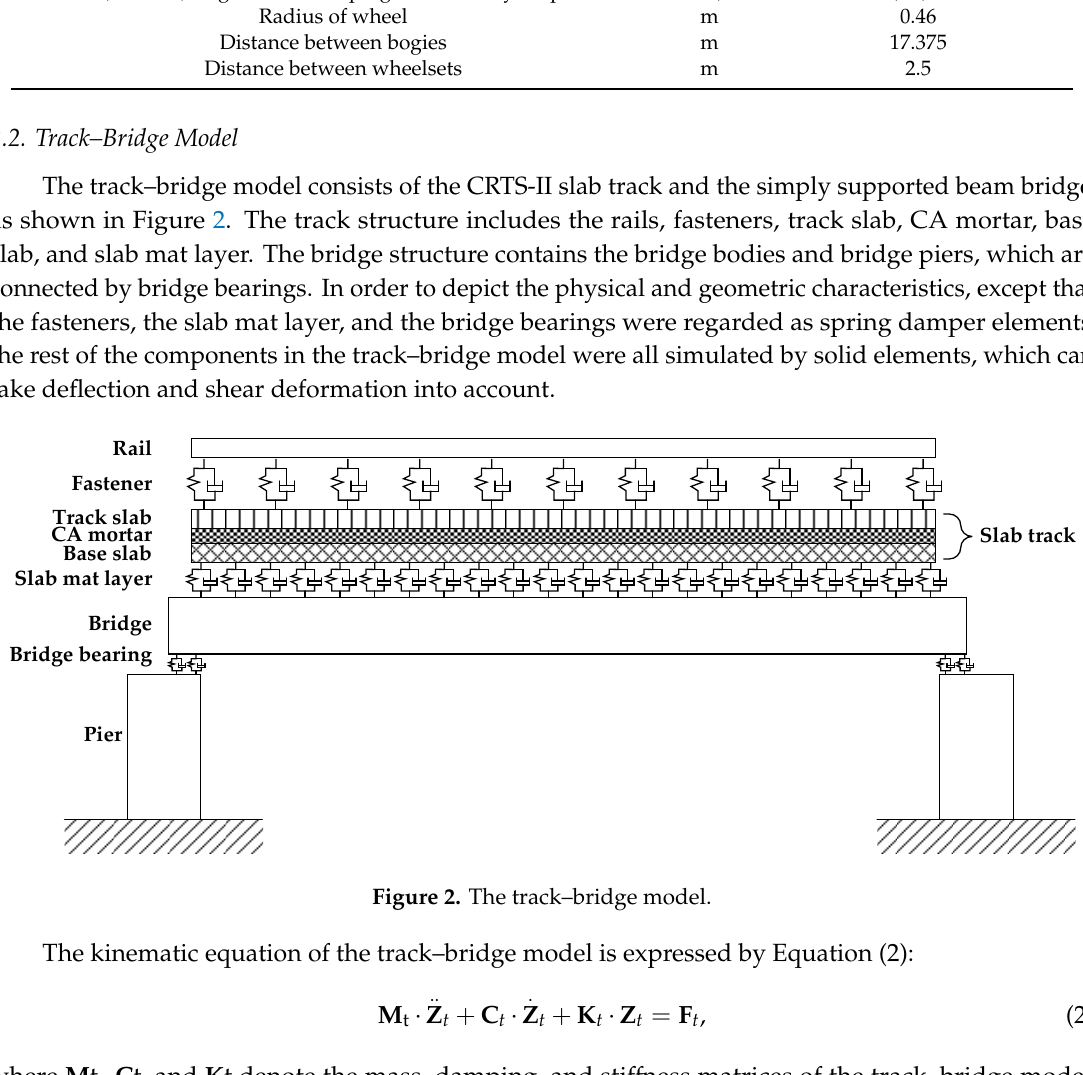
Table 1. The parameters of the CRH3 vehicle.